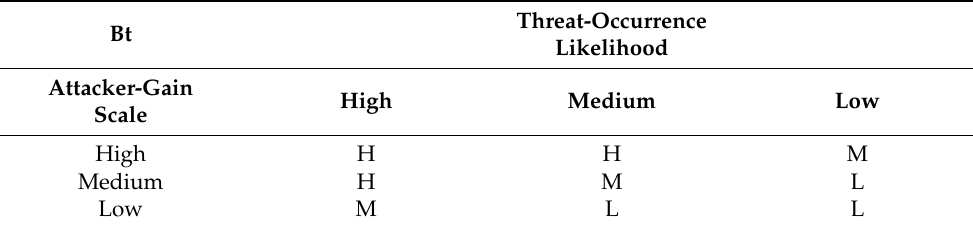
Table 2. Business-as-target matrix.